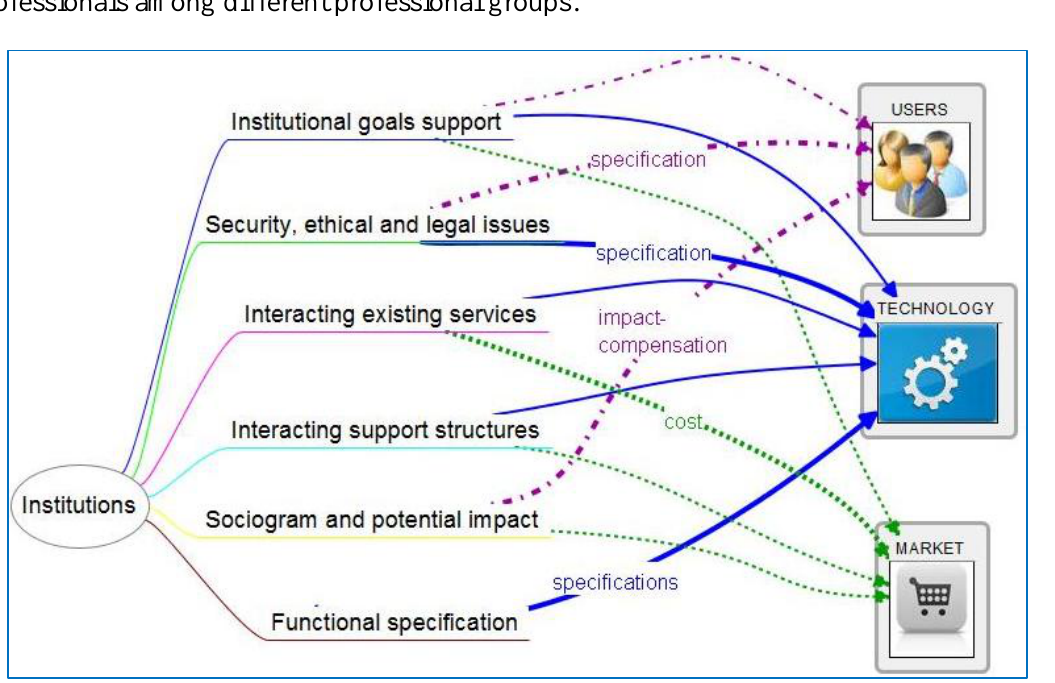
Figure 5. Cross relation of information-bits generated by institutions and social context professionals among different professional